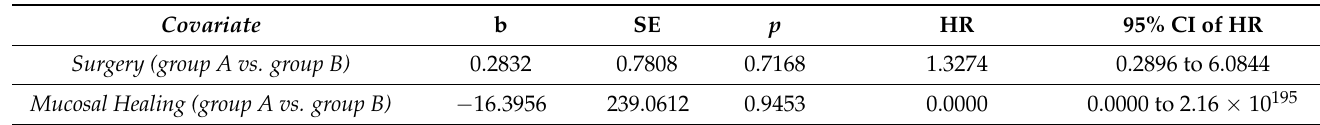
Table 3. Multivariate Cox regression: surgical treatment (resection vs. debridement) is an independent prognostic factor to